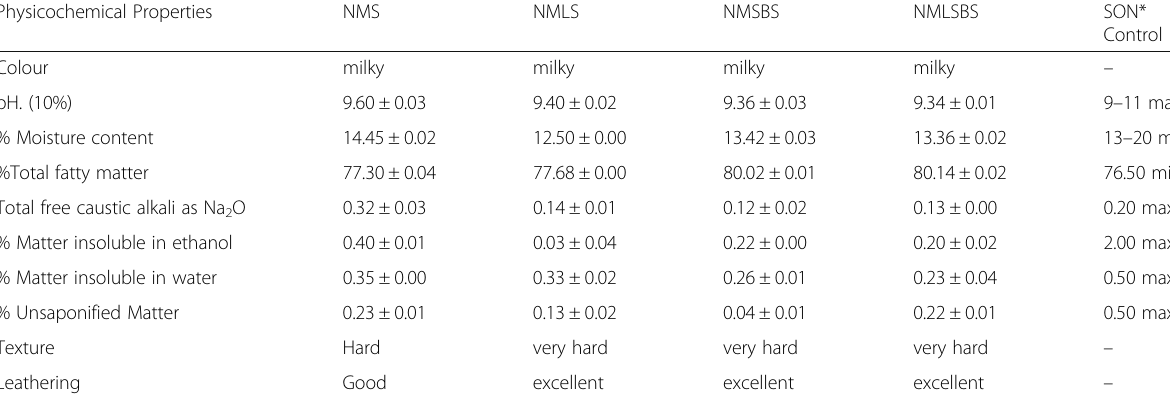
Table 8 Physicochemical properties of neem soap and SON specifications for toilet soap Physicochemical